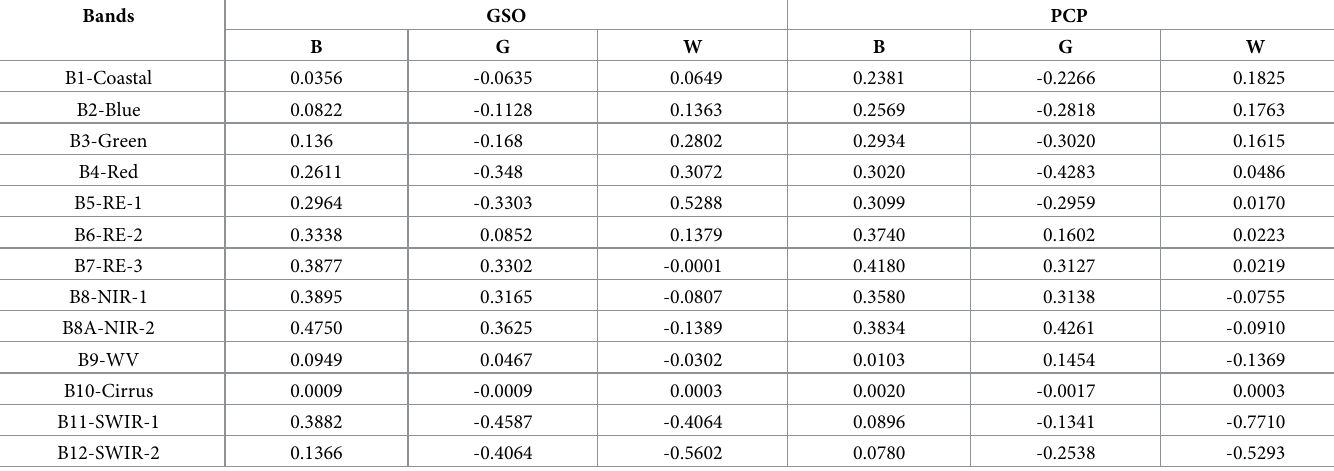
Table 2. K-T transformation coefficients of Sentinel-2 images.